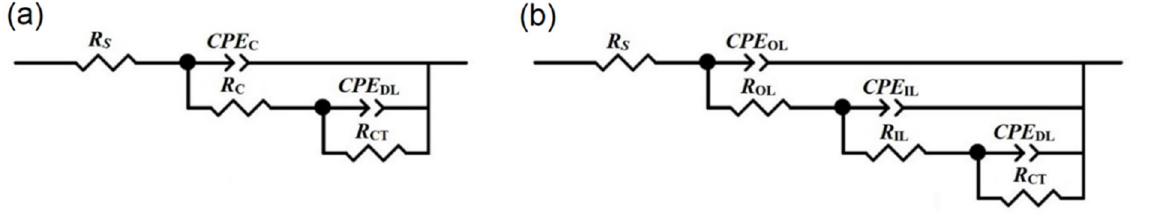
Figure 10. Equivalent circuits used to fit data of EIS measurements: ( a ) uncoated AZ91D Mg alloy; ( b ) PEO-treated